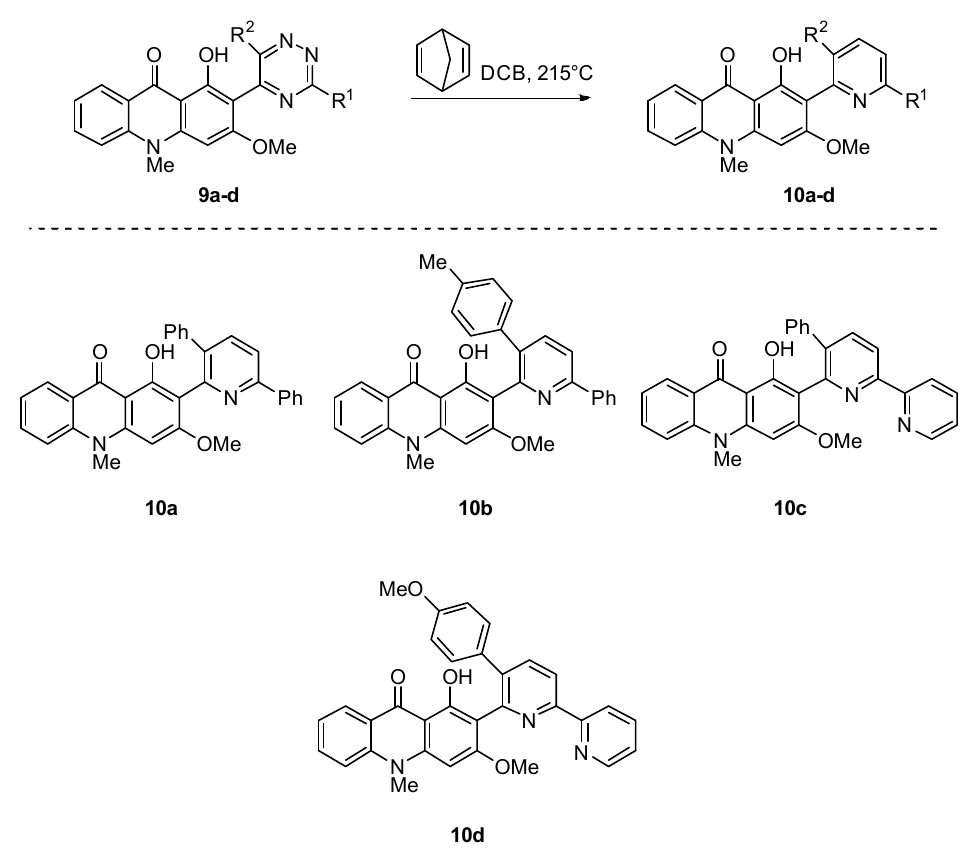
Scheme 3. Synthesis of pyridines 10a – d from triazines 9a – d .